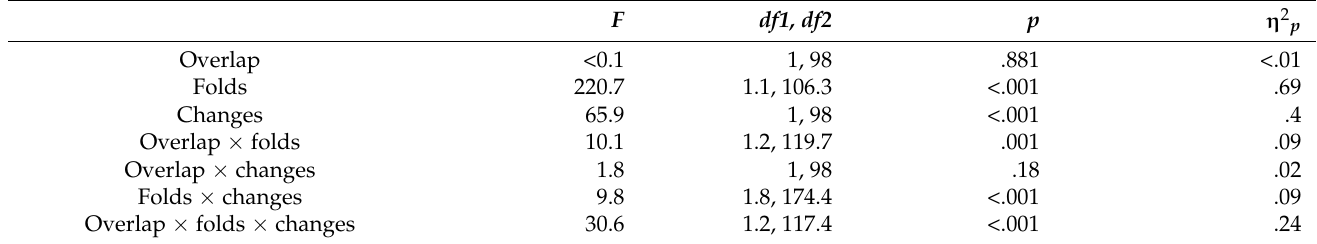
Figure 2. Means and standard errors of reaction times (in seconds), depending on the number of relevant folds (3, 4, or 5), the number of directional changes (0, 1, 2, 3, or 4), and whether the highlighted lines overlap in the cube (overlap or no overlap). To maintain an equal number of factor levels, the data of four folds and two changes were not used in the ANOVA. Table 1. Statistical results of the ANOVA for reaction times. The ANOVA was conducted with the factors overlap , folds , and directional changes .